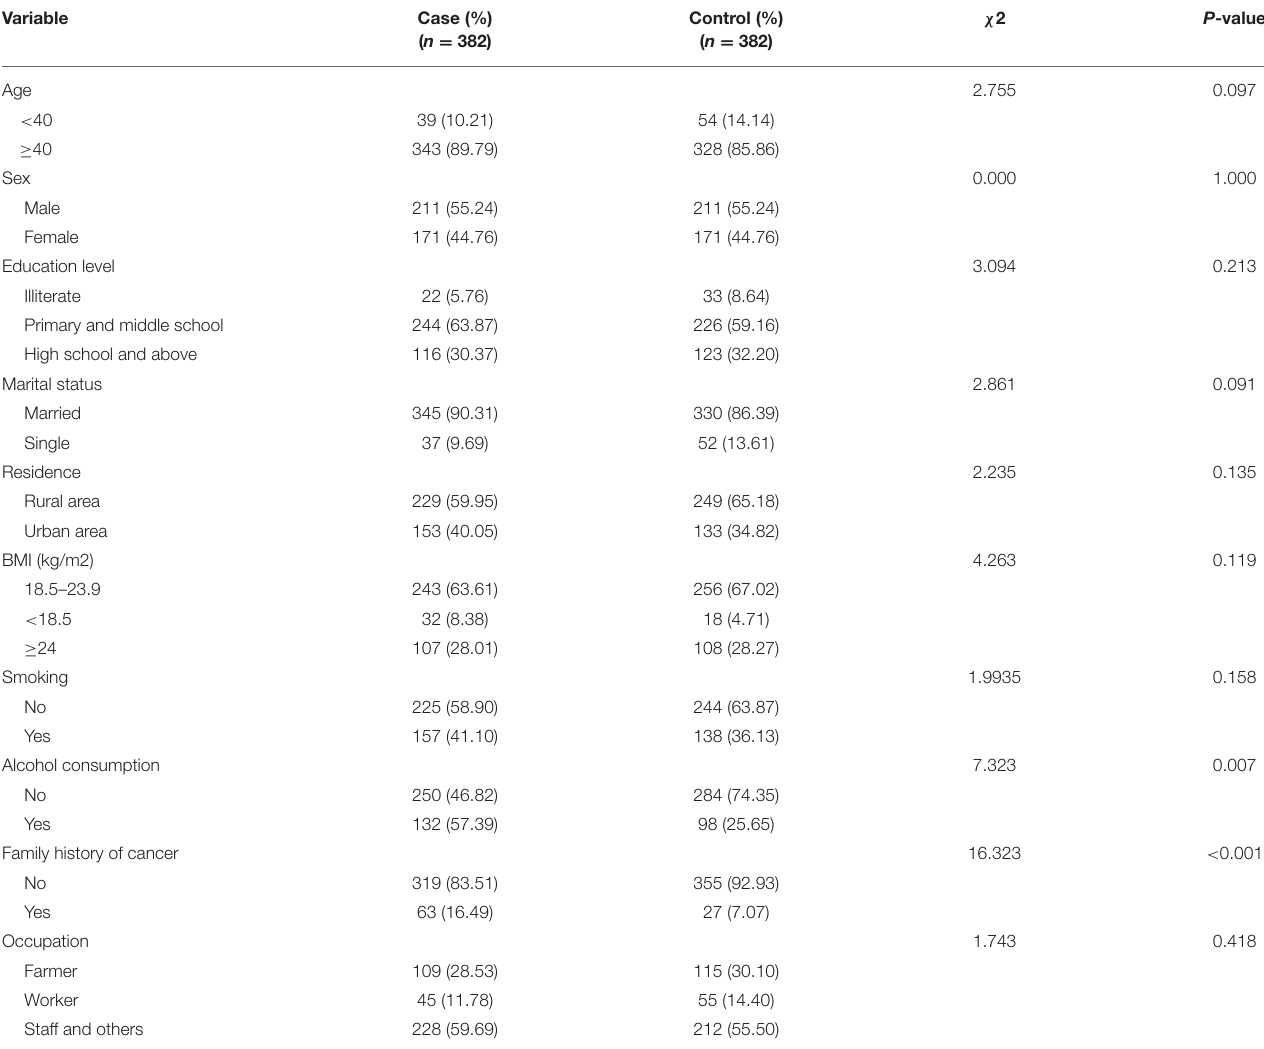
TABLE 1 | Main characteristics of case and control subjects.